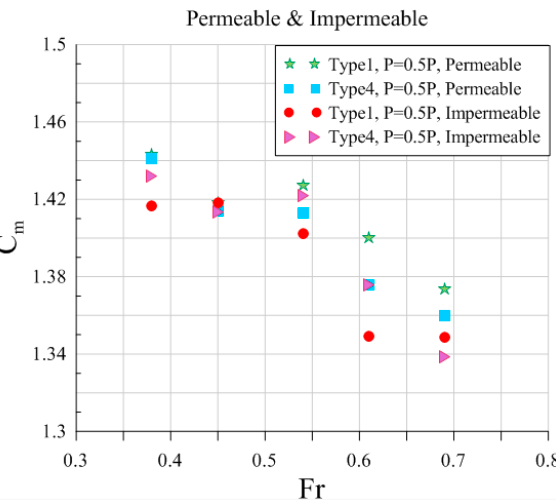
Figure 18. Performance of Permeable and Impermeable Antivortex Types 1 and 4 with a height of 0.5 P.